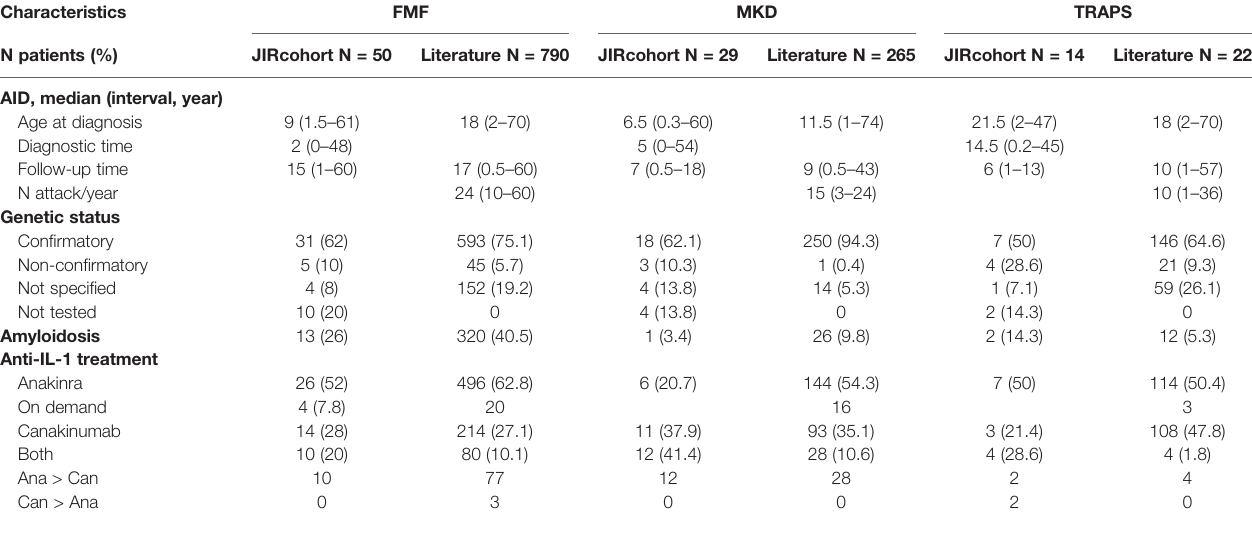
TABLE 1 | Main characteristics: JIRcohort and literature review. IL, interleukin; FMF, familial Mediterranean fever; MKD, mevalonate kinase de fi ciency; TRAPS, tumor necrosis factor receptor-associated periodic syndrome.